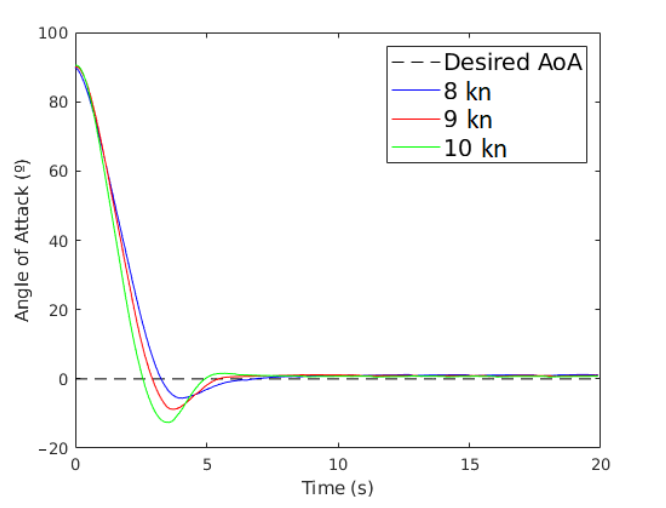
Figure 10. Time response of the wing sail angle of attack (AoA) ( α i = 90°, α f = 0°).